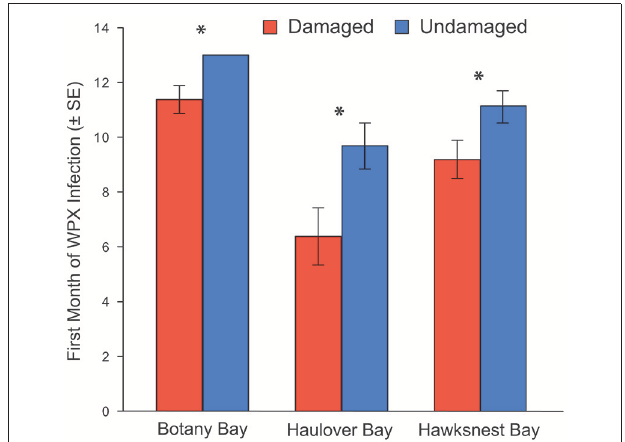
FIGURE 4 | Month of first infection of white pox disease for damaged and undamaged corals at each site. Bars represent an average of all corals for each category. Corals that did not have white pox disease during the 12-month study were given a rank of 13. Asterisks indicate a statistically significant